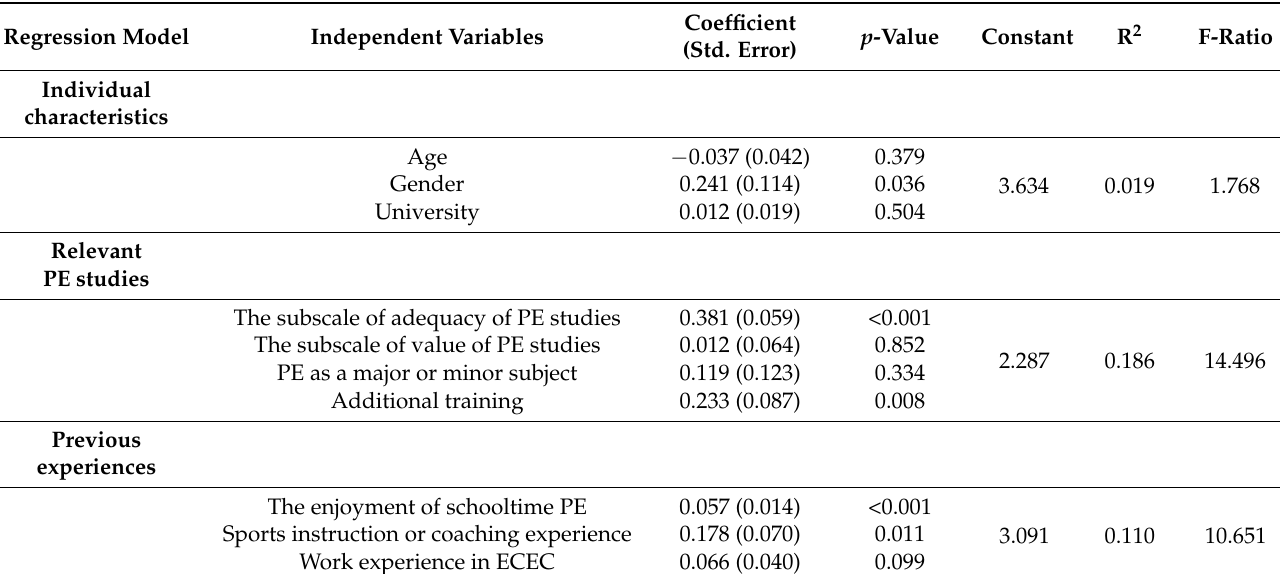
Table 4. Linear regression results for teaching PE.